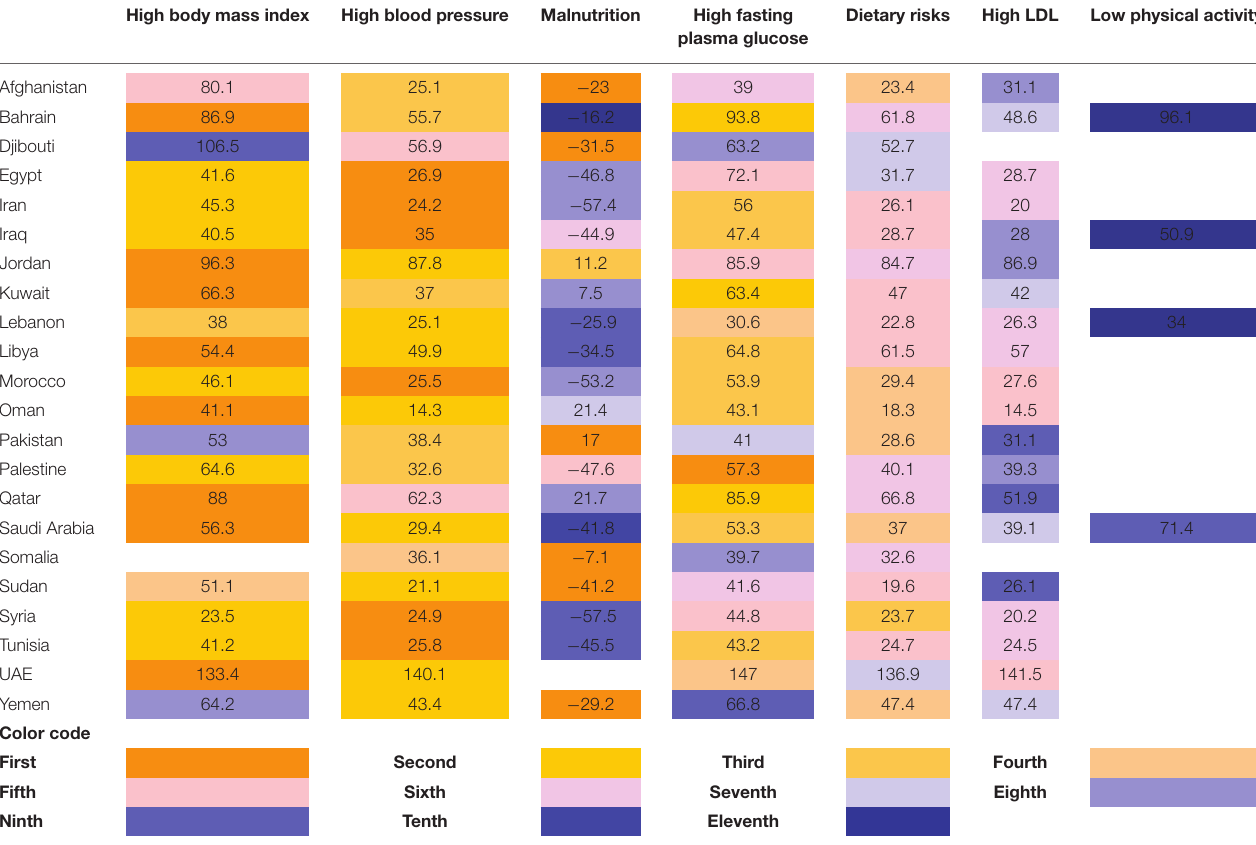
TABLE 5 | The rank of the nutrition related risk factors that causes deaths in 2019 and the percentage change between 2009–2019 (13). High body mass index High blood pressure Malnutrition High fasting